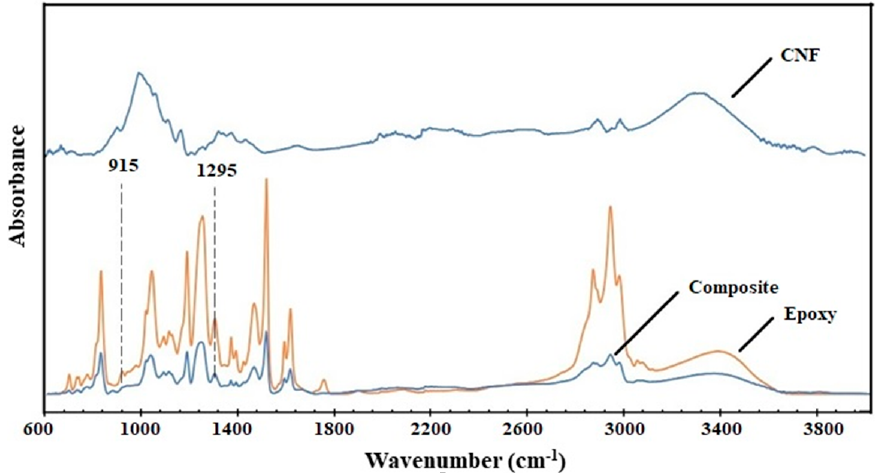
Figure 5. FTIR spectra representative of CNF, neat cured epoxy resin, and composites.